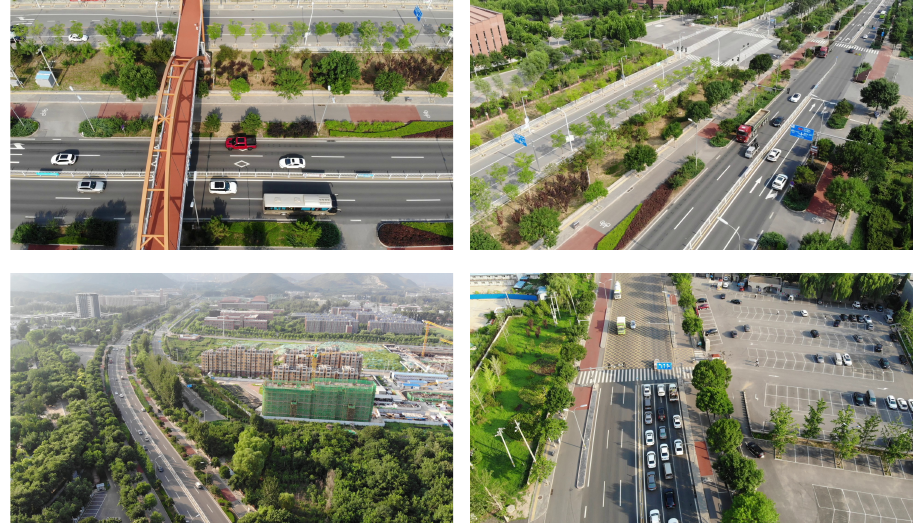
Figure 5. Overlooking view of the shooting